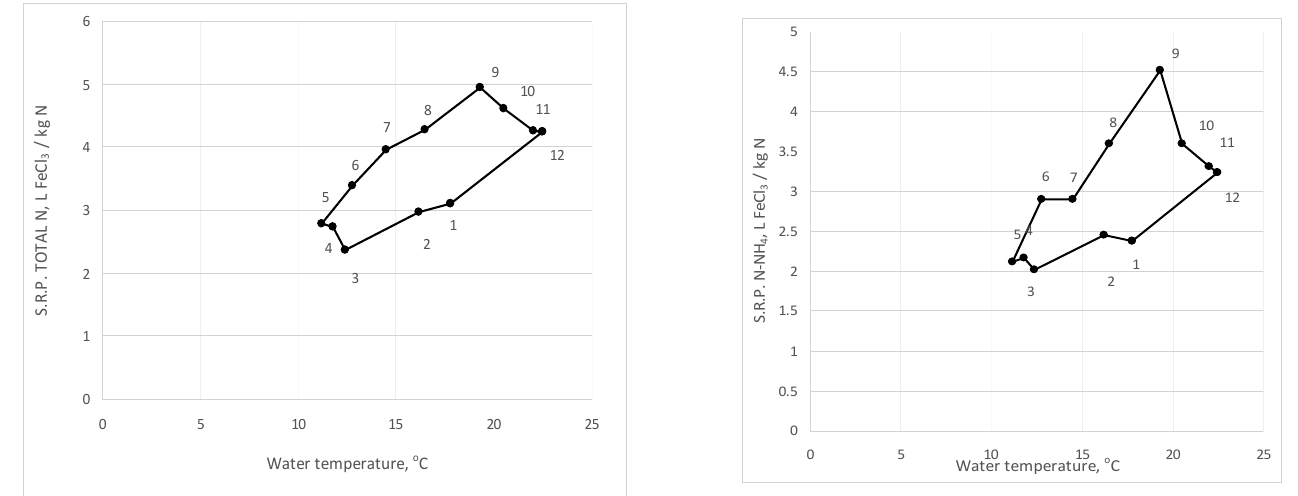
Figure 8. Correlations between water temperature and specific removal power for: Left : total nitrogen; Right : ammonia nitrogen.